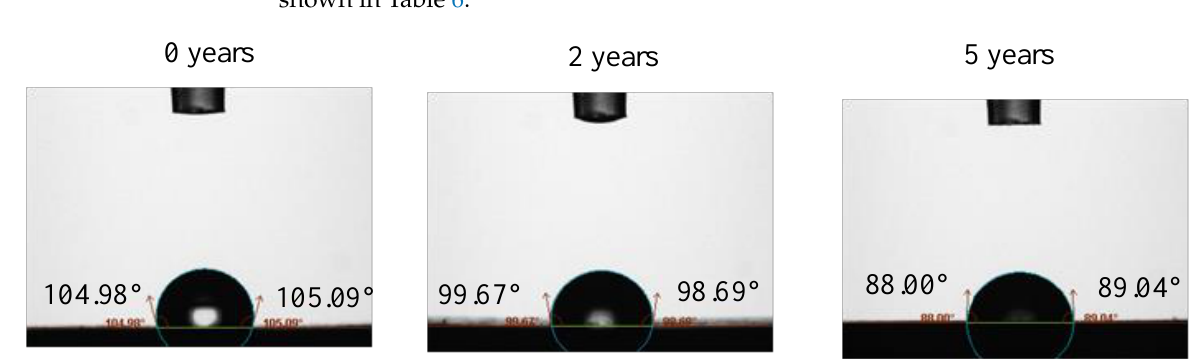
Figure 17. The static contact angle of the samples after 10 min.